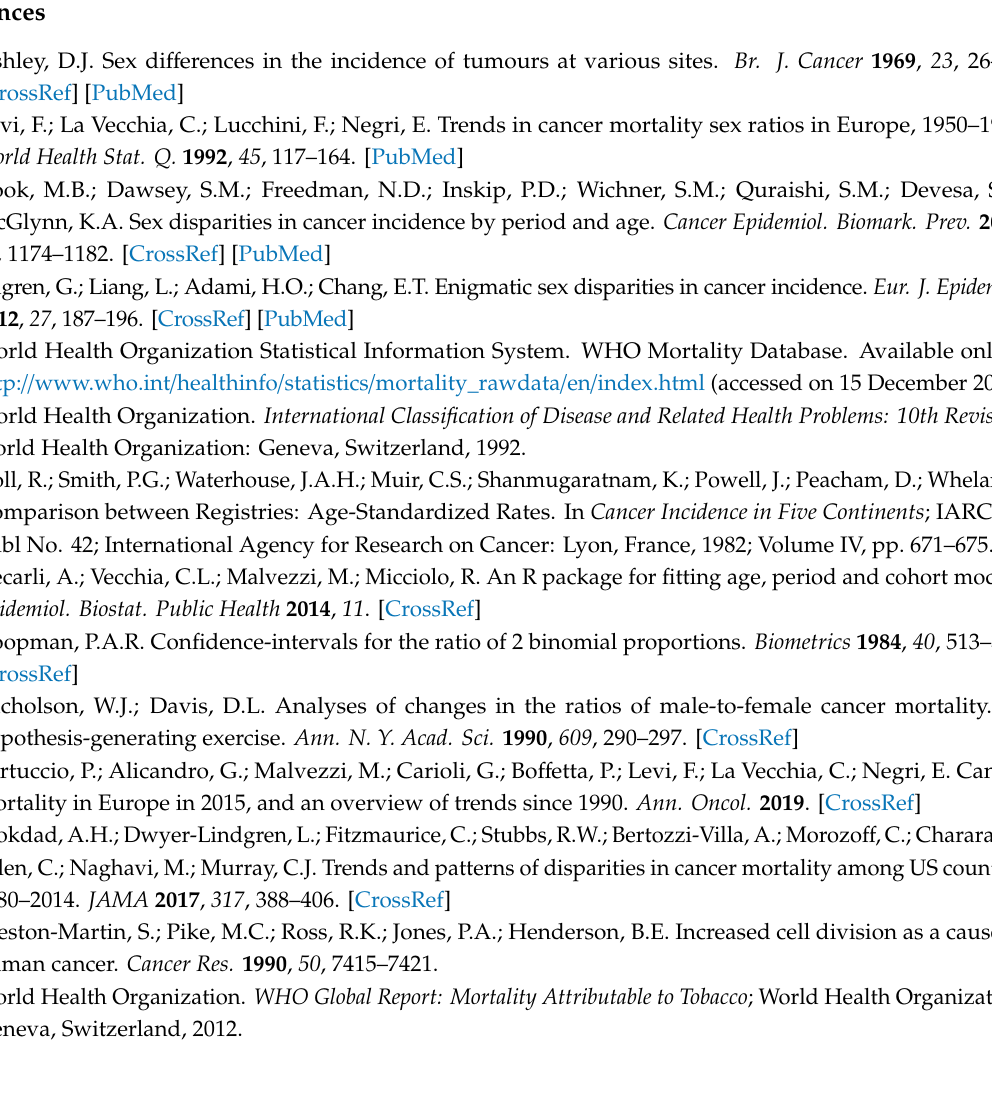
Table S1: Average populations over the 1970–1974 and 2010–2014 quinquenniums by 5 year age groups and sex with total population, mean and median ages, for the EU, the USA and